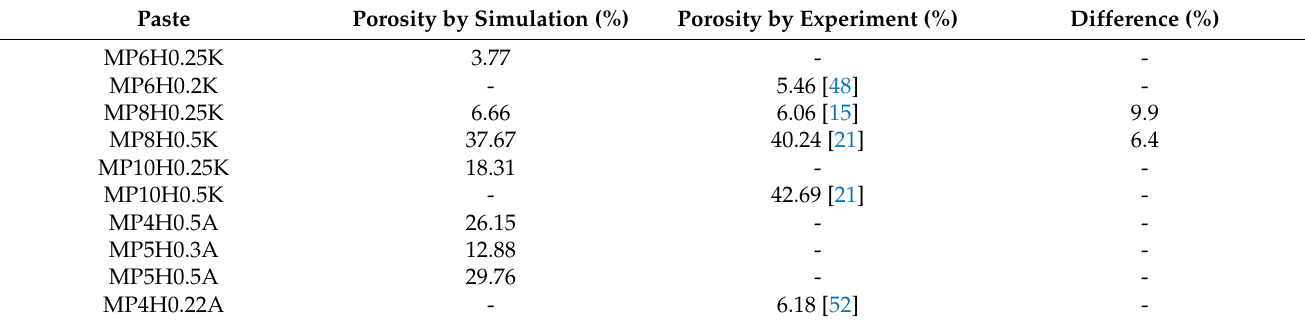
Table 8. Comparison of porosities among simulated and experimental